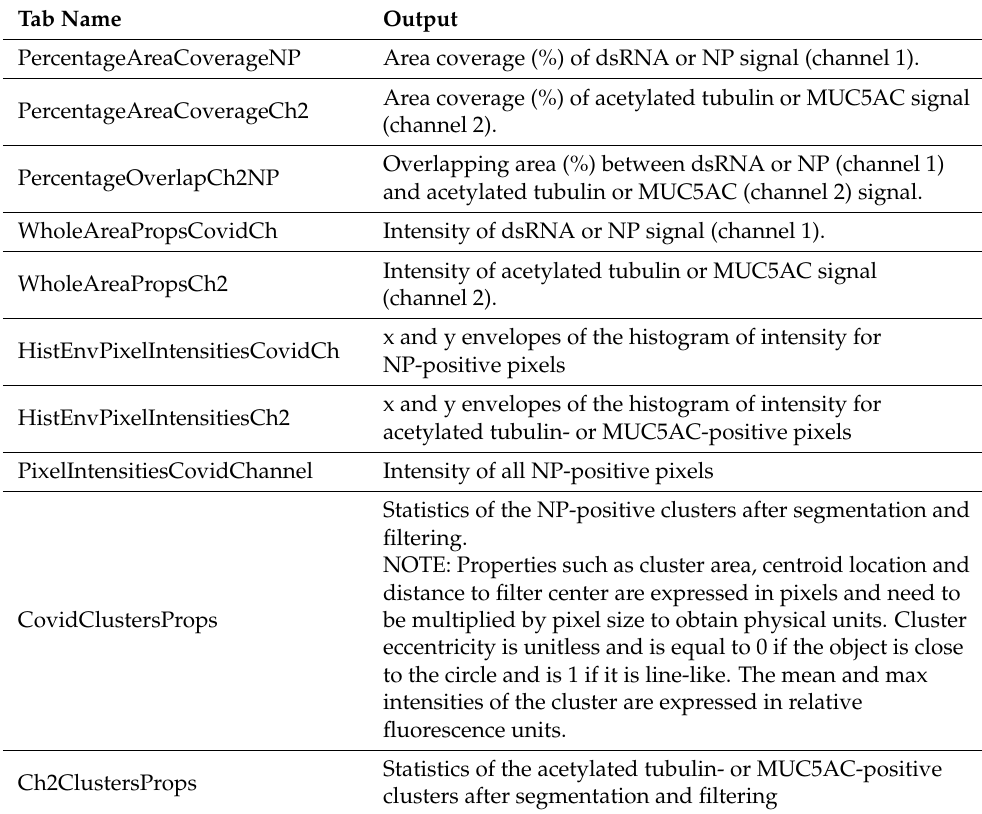
Table 3. Example statistics generated from the GUI